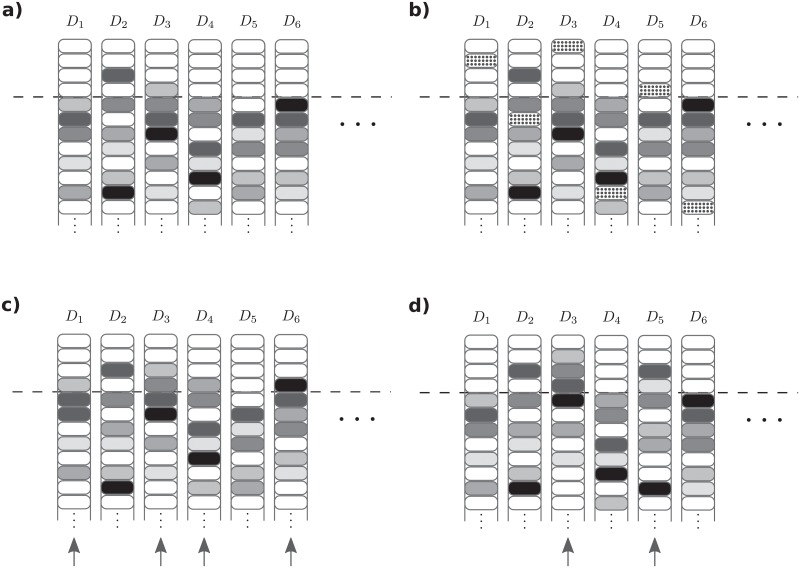
Schematic representation of the ordering in interaction lists (ILists) and their modification in the presence of anomalies.ILists for six detectors of the same subtype are represented schematically. White boxes represent signals delivered by presenters of the opposite subtype, and boxes in different grey shades represent signals delivered by different presenters of the same subtype of the detector. Only signals displayed by presenters for a given sample are represented; all others play no role in the dynamics and are omitted. a) ILists ordering when a normal sample is presented. Most detectors have on top positions—delimited by the dashed line—only signals delivered by agents of the opposite subtype. b) When a rare signal (represented in dotted boxes) that was not presented during training appears, detectors rank it in arbitrary positions; detectors D1, D3 and D5 can establish long lived interactions. c) When the number of frequently displayed signals going absent increases beyond what is typical during training, then several detectors can have less signals delivered by presenters of the opposite subtype on top positions (detectors D1,D3,D4 and D6), which can shift the remaining signals upwards mildly but on a large number of detectors. d) Even if the number of absent frequent signals is not larger than experienced during training, detection can be triggered if the absent signals were never absent together. In that case, shifts upwards in ILists can be stronger, although may affect a smaller number of ILists (detectors D3 and D5).